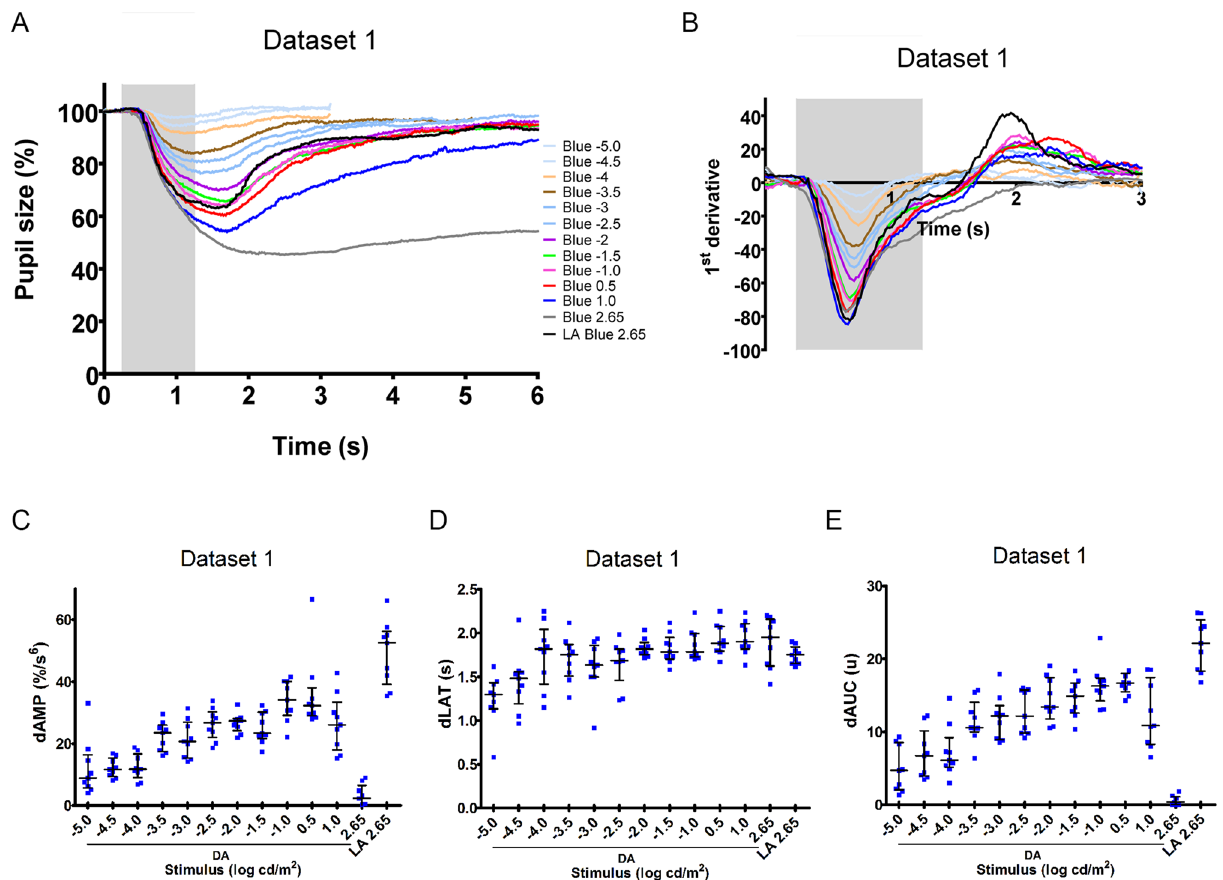
Figure 1. Pupil response curve and derivative analysis of Dataset 1 to blue light stimuli s presented under dark- adapted condition. ( A ) The mean relative pupil size (plain line) before, during and after a 1 s light stimulus is plotted against time (response curve). The different colors represent the different stimulus intensities from − 5 log cd/m 2 to 2.65 log cd/m 2 . ( B ) The mean derivative responses plotted for the first 3 s of the pupil recordings shown in ( A ). LA Blue represents the pupil response to the blue light stimulus 2.65 log cd/m 2 presented at the end of a light-adapted sequence. The shaded box represents the duration of the light stimulus. Three parameters were obtained by quantification of the derivative curve: the maximal positive peak amplitude (dAMP) ( C ), the latency of dAMP ( D ) and the area under the curve of the positive peak of the derivative (dAUC) ( E ) are presented as distribution plots. The median (long horizontal bar) and the interquartile range (short horizontal bar) are superposed at each stimulus intensity. LA: light-adapted; DA: (Fig. 1A). This absence of active dilation in the early dynamic phase is confirmed by an absence of positive peak amplitude on the derivative response curve (Fig. 1B) and a dAMP of zero (Fig. 1C). The dLAT (derivative latency time to the maximal positive peak amplitude) is shown for all subjects of data- sets 1 and 2 in scatterplots Figs. 1D and 2D respectively. The dLAT appears to be a fairly stable parameter, not intensity dependent, with medians from 1.8 to 2.0 s for all stimuli except the 2 dimmest (− 5 and − 4.5 log cd/ m 2 , Table 1). We point out that the value of the dLAT is measured from the onset of light stimulus whereas the derivative response curves of Figs. 1B and 2B begin with 250 ms of baseline before the stimulus onset. As the dLATs for the 2 dimmest stimuli were generally shorter and/or highly variable compared to the other stimuli, we considered the responses to these 2 dimmest stimuli not reliable and below the threshold for quantification for all further analysis. The dAUC (derivatives area under the curve of the positive peak) is shown in a scatterplot as a function of stimulus intensity (Figs. 1E and 2E). Because we had identified the dLATs to the 2 dimmest stimuli (− 5 and − 4.5 log cd/m 2 ) as non-valid, we used the mean AUC of these 2 dimmest stimuli to determine a minimum AUC value which was considered valid for this study. The minimum AUC is 10 (in arbitrary units). An AUC equal to or greater than 10 indicates a rapid pupillary dilation movement following a light-evoked pupillary constriction (Figs. 1E and 2E). For dataset 1, dAUCs of dark-adapted responses increased with increasing stimulus intensity until a maxi- mum dAUC at 0.5 log cd/m 2 . From 1 log cd/m 2 dAUC values decreased and became negligible at 2.65 log cd/ m 2 (< 10 arbitrary units), consistent with the observed sustained pupillary constriction observed at this bright intensity (Fig. 1A). Moreover, the maximal dAUC value is presented by the response to the light-adapted blue light 2.65 log cd/m 2 , consistent with the tracing shown in Fig. 1B. For dataset 2, dAUC values increased with